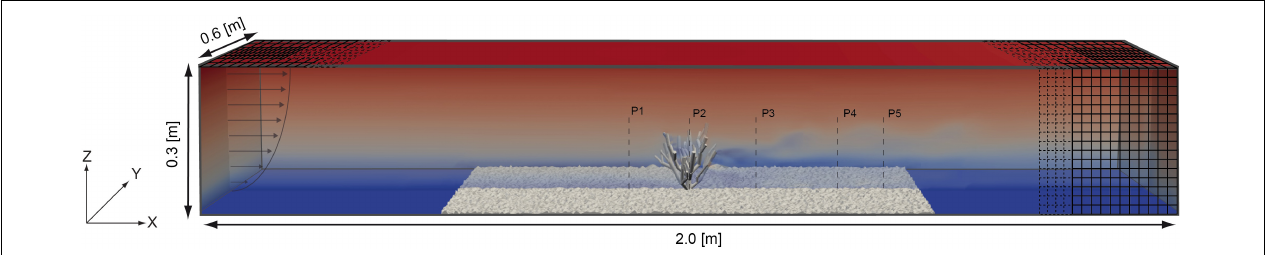
FIGURE 2 | Setup of the numerical model domain showing the position of the roughness elements and the cold-water coral model as well as the exact locations of the processed fluid profiles. The profile on the left indicates the flow distribution at the inlet. The mesh at the right side indicates the used resolution levels used in the numerical